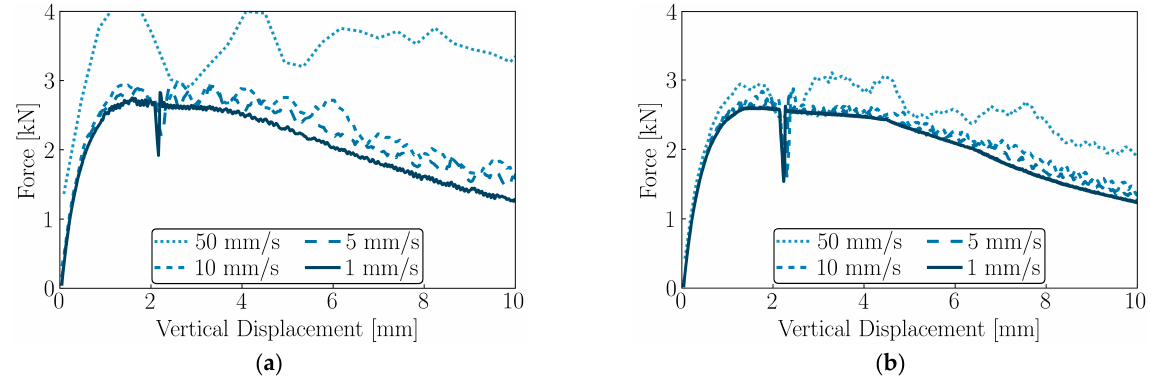
Figure 7. Velocity sensitivity results for ( a ) Pulatsu’s geometry and for ( b ) the 12 mm surface mesh.